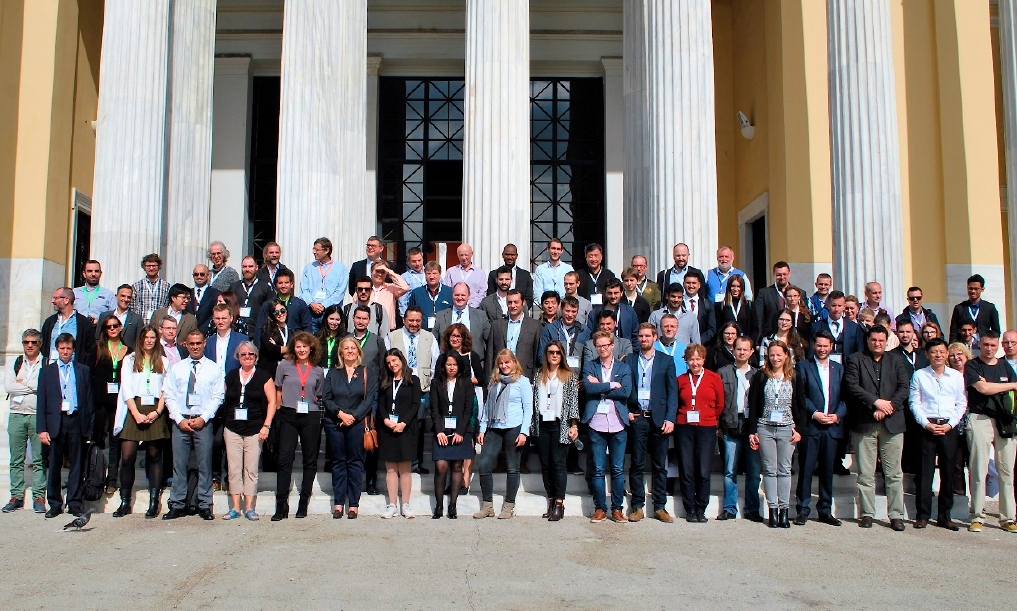
Figure 1. Participants of the 3D Cadastres workshop in Athens 2016.